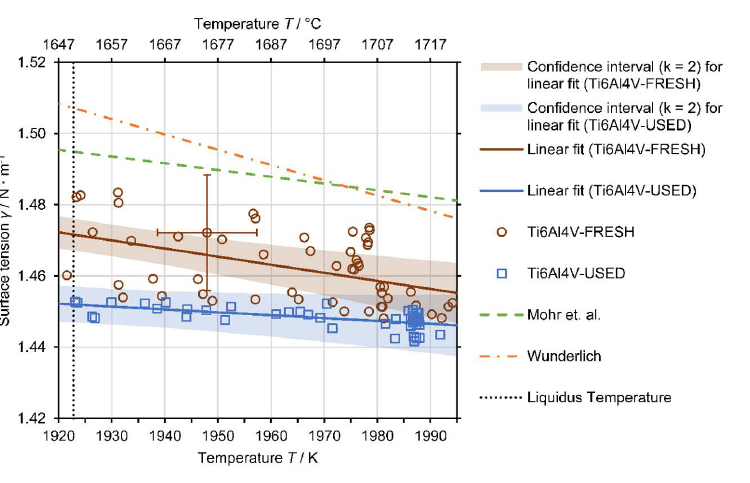
Figure 7. Results of the single surface tension measurements of FRESH (red circles) and USED (blue squares) Ti6Al4V, linear fits (solid red and blue lines) in accordance with the linear models (6), (7) and confidence intervals (k = 2, shaded red and blue areas) for the fits. Only one uncertainty bar indicating the typical measurement uncertainty of the individual data points is shown to facilitate better readability of the figure; see Appendix A.2.5 for more information about the uncertainty analysis. As a comparison, the reference data by Mohr et al. [49] ( µ -g experiments on-board the International Space Station (ISS)) are plotted as a green dashed line and the average of two datasets by Wunderlich [50] ( µ -g experiments on parabola flight) as an orange dash dotted line. The melting temperature of 1928 K by Boivineau et al. [47] is plotted as a dotted black